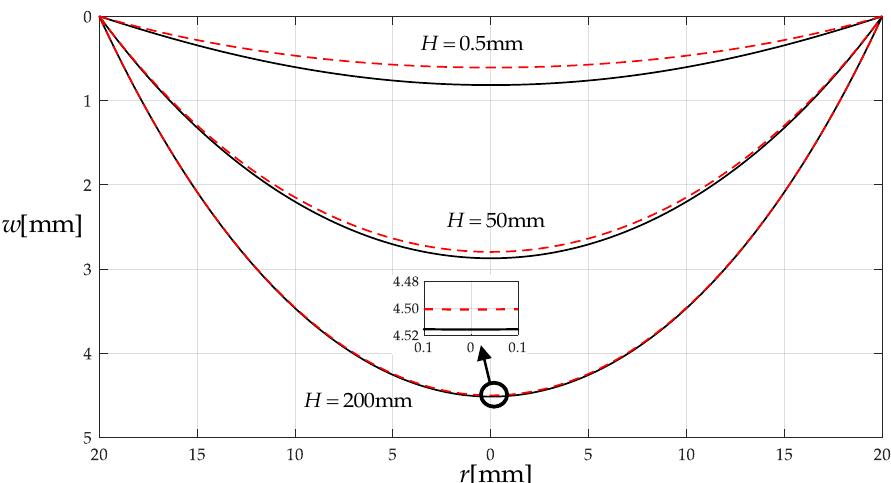
Figure 3. Deflection w along radius r when H takes 0.5 mm, 50 mm and 200 mm, respectively, where the solid lines by the solution presented in this paper and the dotted lines by the well-known Hencky solution.